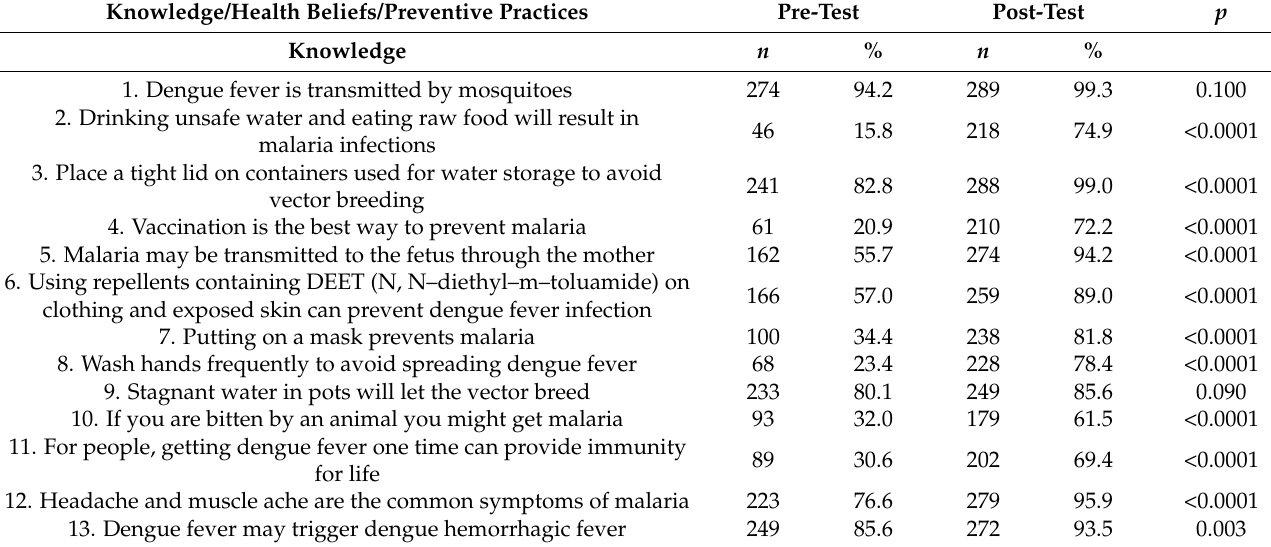
Table 2. Correct number and percentage for knowledge items about mosquito-borne diseases and item scores of health beliefs and preventive practices toward mosquito-borne diseases before and after implementation of the health education program ( n =